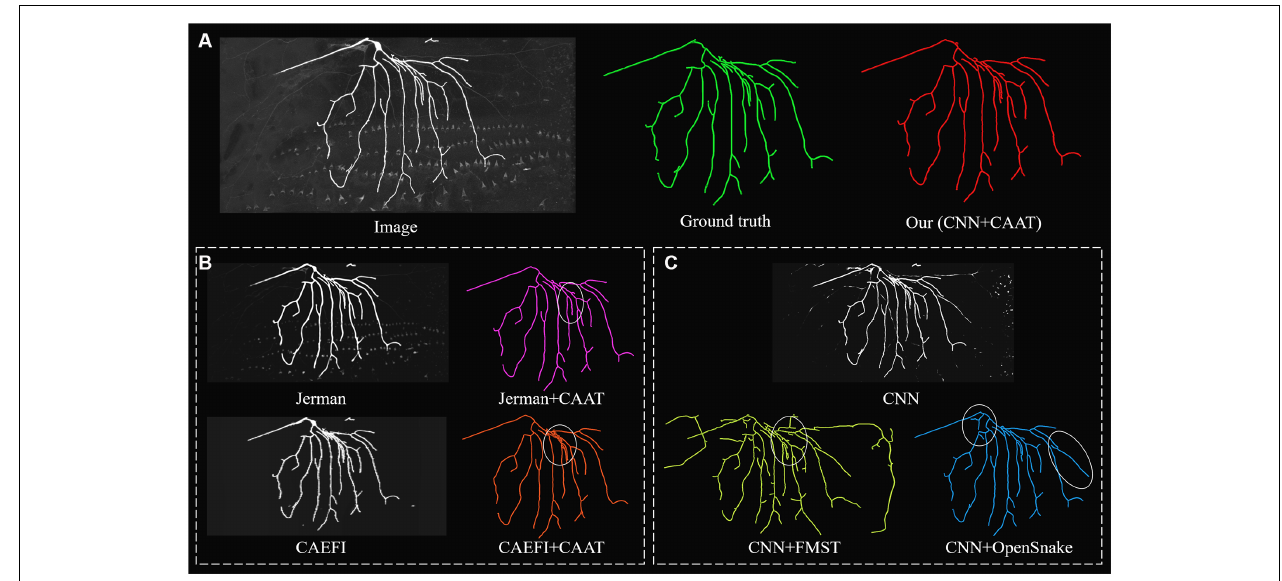
FIGURE 5 | Comparative performances of ablation studies on a complex and noisy big neuron image to illustrate the role of CNN prediction and CAAT of the proposed method, by applying current novel enhancement methods [Jerman filter (Jerman et al., 2015) and CAEFI (Jeelani et al., 2019)] to replace CNN prediction (B) and tracing methods [FMST (Yang et al., 2019) and OpenSnake (Wang et al., 2011)] to replace CAAT (C) alternatively. Comparative tracing results of gold standard and our method (A) . Inaccurate traced areas were marked by white ellipses.